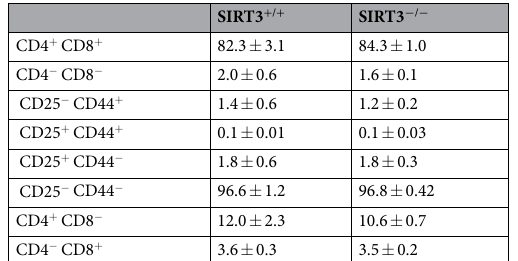
Table 1. Thymic cell subsets in SIRT3 + / + and SIRT3 − / − mice. Data are means ± SD of 4 animals per group and expressed as the percentage of total cells (CD4 + CD8 + , CD4 − CD8 − , CD4 + CD8 − and CD4 − CD8 + ) or percentage of CD4 − CD8 − parental cells (CD25 − CD44 + , CD25 + CD44 + , CD25 + CD44 − and CD25 − CD44 − ). Total cell numbers were 49.2 ± 15.4 and 47.4 ± 6.9 millions per thymus in SIRT3 + / + and SIRT3 − / − mice, respectively. No statistically significant differences in subsets’ percentages and absolute numbers were detected.